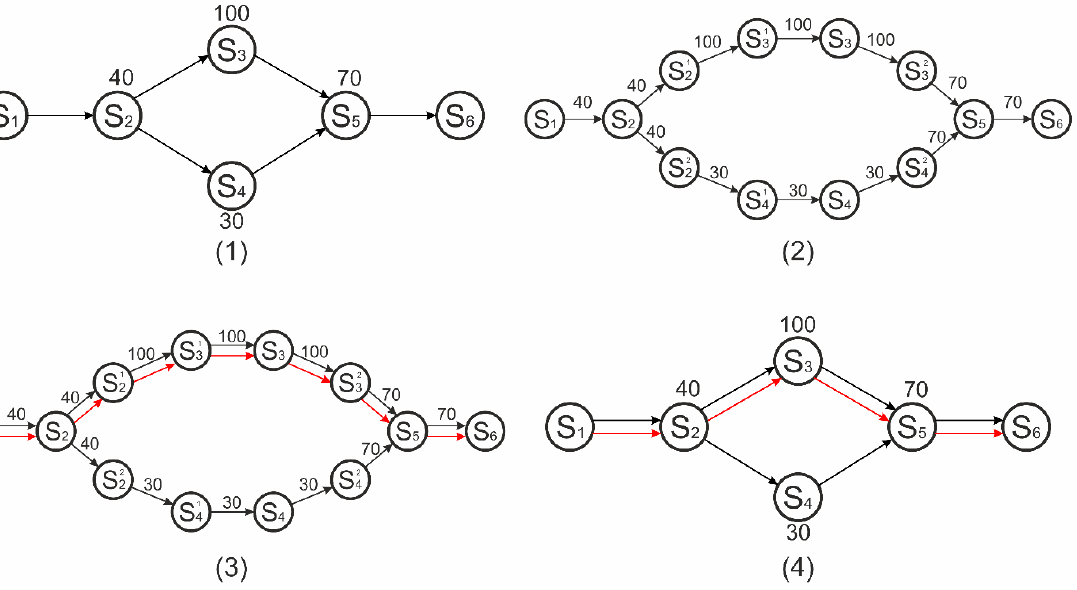
Figure 4. Sensors change approach using an example.